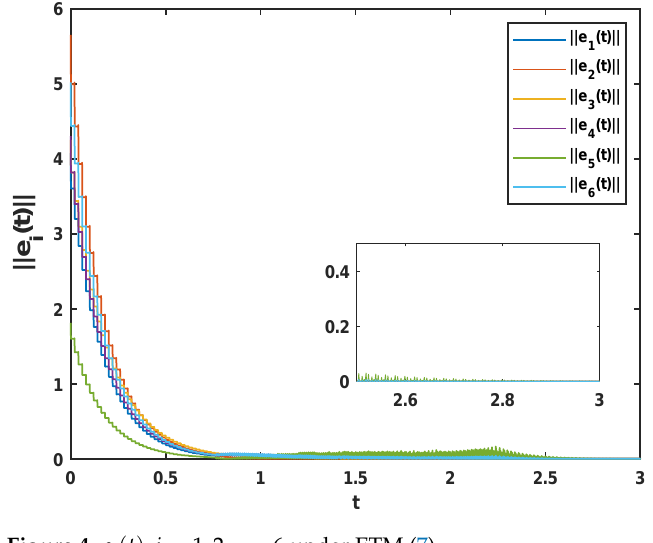
Figure 4. e i ( t ) , i = 1,2, . . . ,6 under ETM (7). Finally, the event-triggered impulsive series are presented in Figure